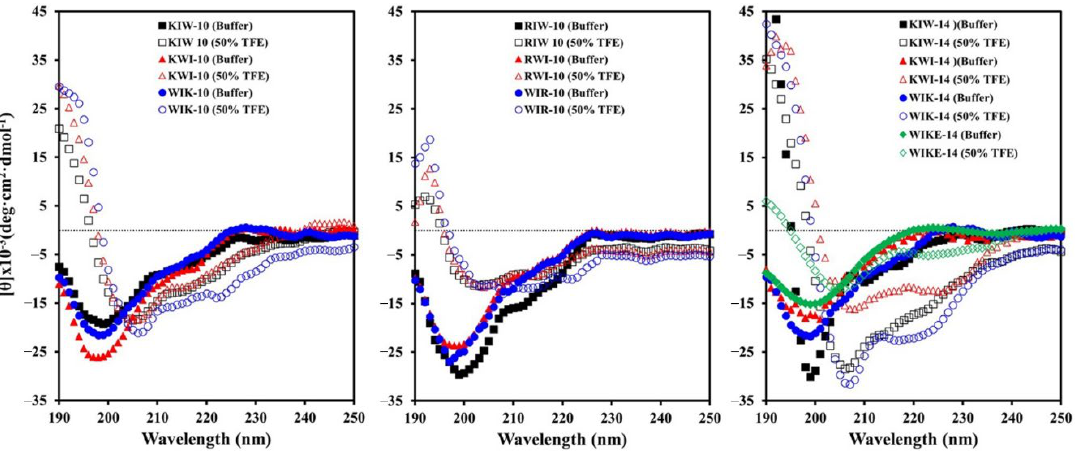
Figure 2. Secondary structures of XIW peptides in buffer and 50% TFE solutions. Peptides (50 µM) suspended in 10 mM sodium phosphate buffer (pH 7.2) and 50% TFE solutions were analyzed using a circular dichroism (CD) spectrometer.